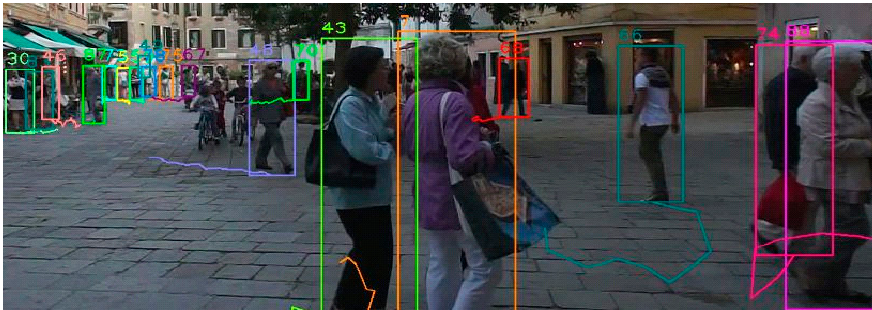
Figure 4. The proposed model (SCT) results using MOT16-02.